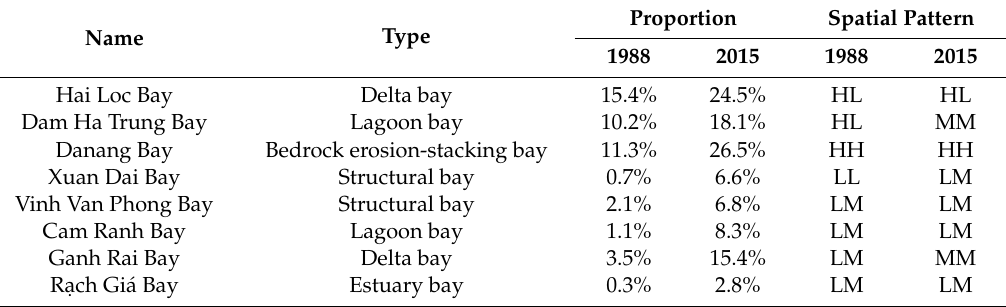
Table 9. Types, proportions and spatial patterns of construction land in each